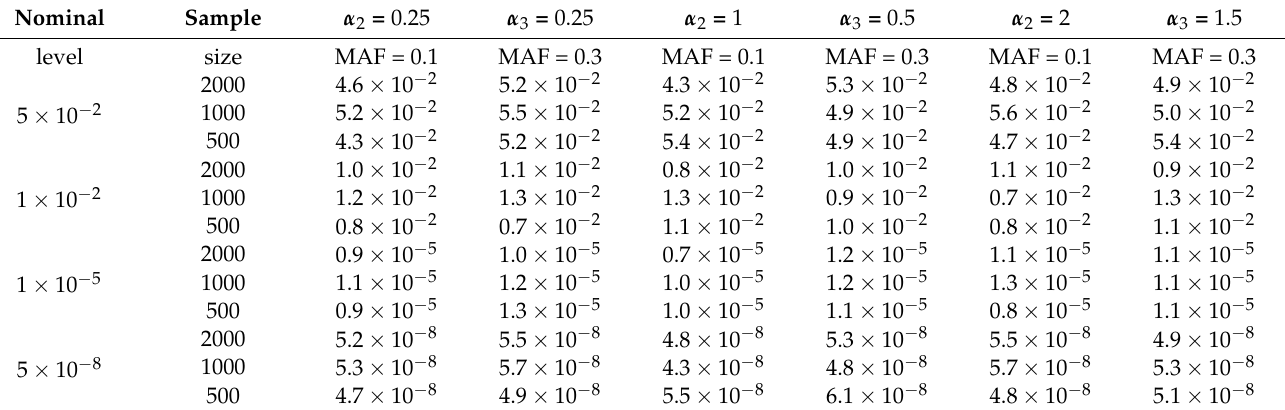
Table 1. Empirical type I error rates of CMAX3 with different nominal levels.